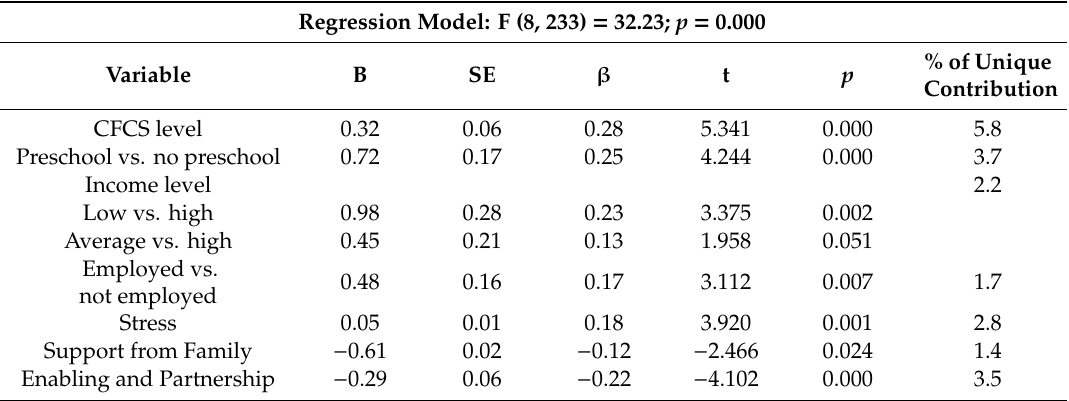
Table 13. Multiple regression model explaining family needs for community